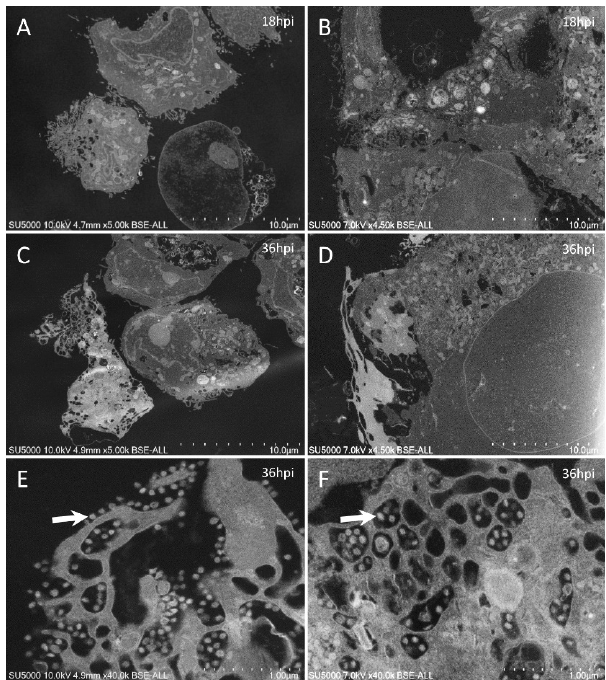
Figure 2. Ultra-thin sections of SARS-CoV-2-infected Vero E6 cells: comparison between images obtained by our classical methodology [9] (left column) and our new approach (right column). In sections obtained from a pellet of SARS-CoV-2-infected cells ( A , C ), cells were generally isolated and separated from each other, while in sections of SARS-CoV-2 monolayers ( B , D ), cells were usually clustered, contacting each other, and more spread out. With our new approach, SARS-CoV-2 particles (arrows) could be recognized ( F ), as was the case when using our classical methodology ( E ).